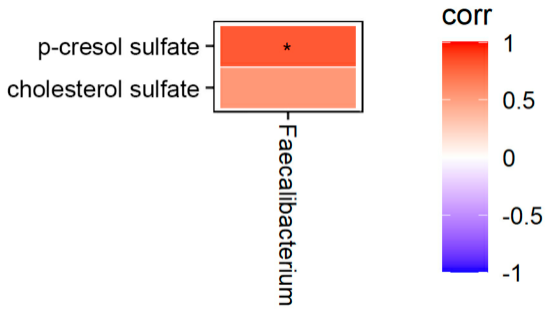
Figure 3. The correlation analysis between metabolites and microbiota in the cecal content. Each row represents a metabolite with color coding that indicates the correlation between fecal metabolites and the gut microbiota. The correlation of each metabolite was normalized in the range of − 1 to 1. Blue ( − 1) and red (1) represent the lowest and highest levels, respectively. * p < 0.05.